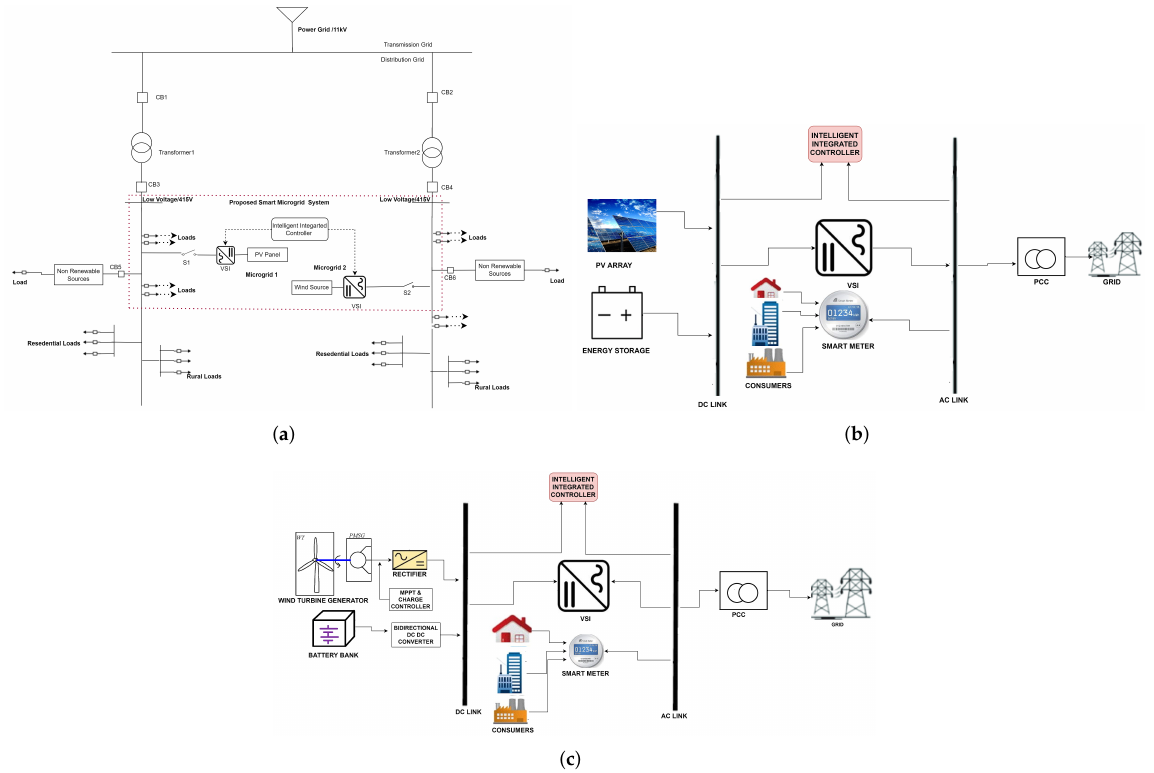
Figure 3. Proposed smart microgrid system with IIC: ( a ) overall electrical drawing with solar- and wind-powered microgrids, ( b ) Microgrid 1 with IIC, ( c ) Microgrid 2 with